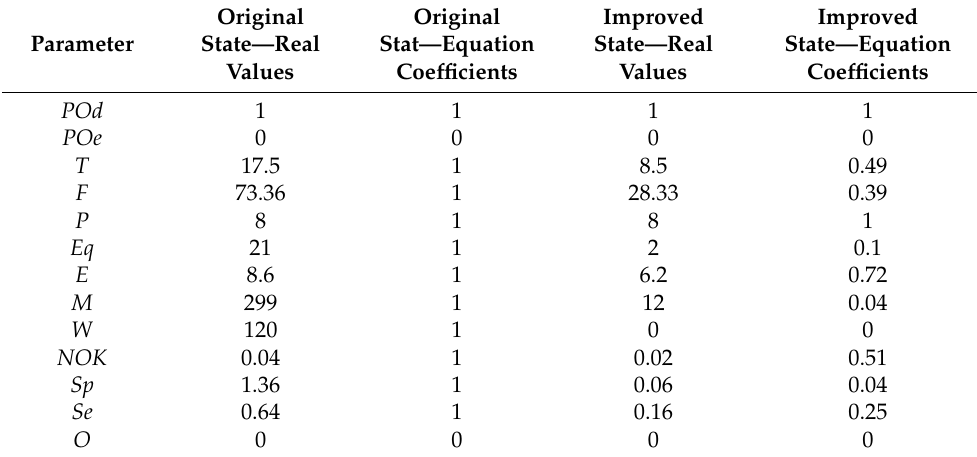
Table 6. Parameters for calculation of process ideality—improved to innovated state (packing process).